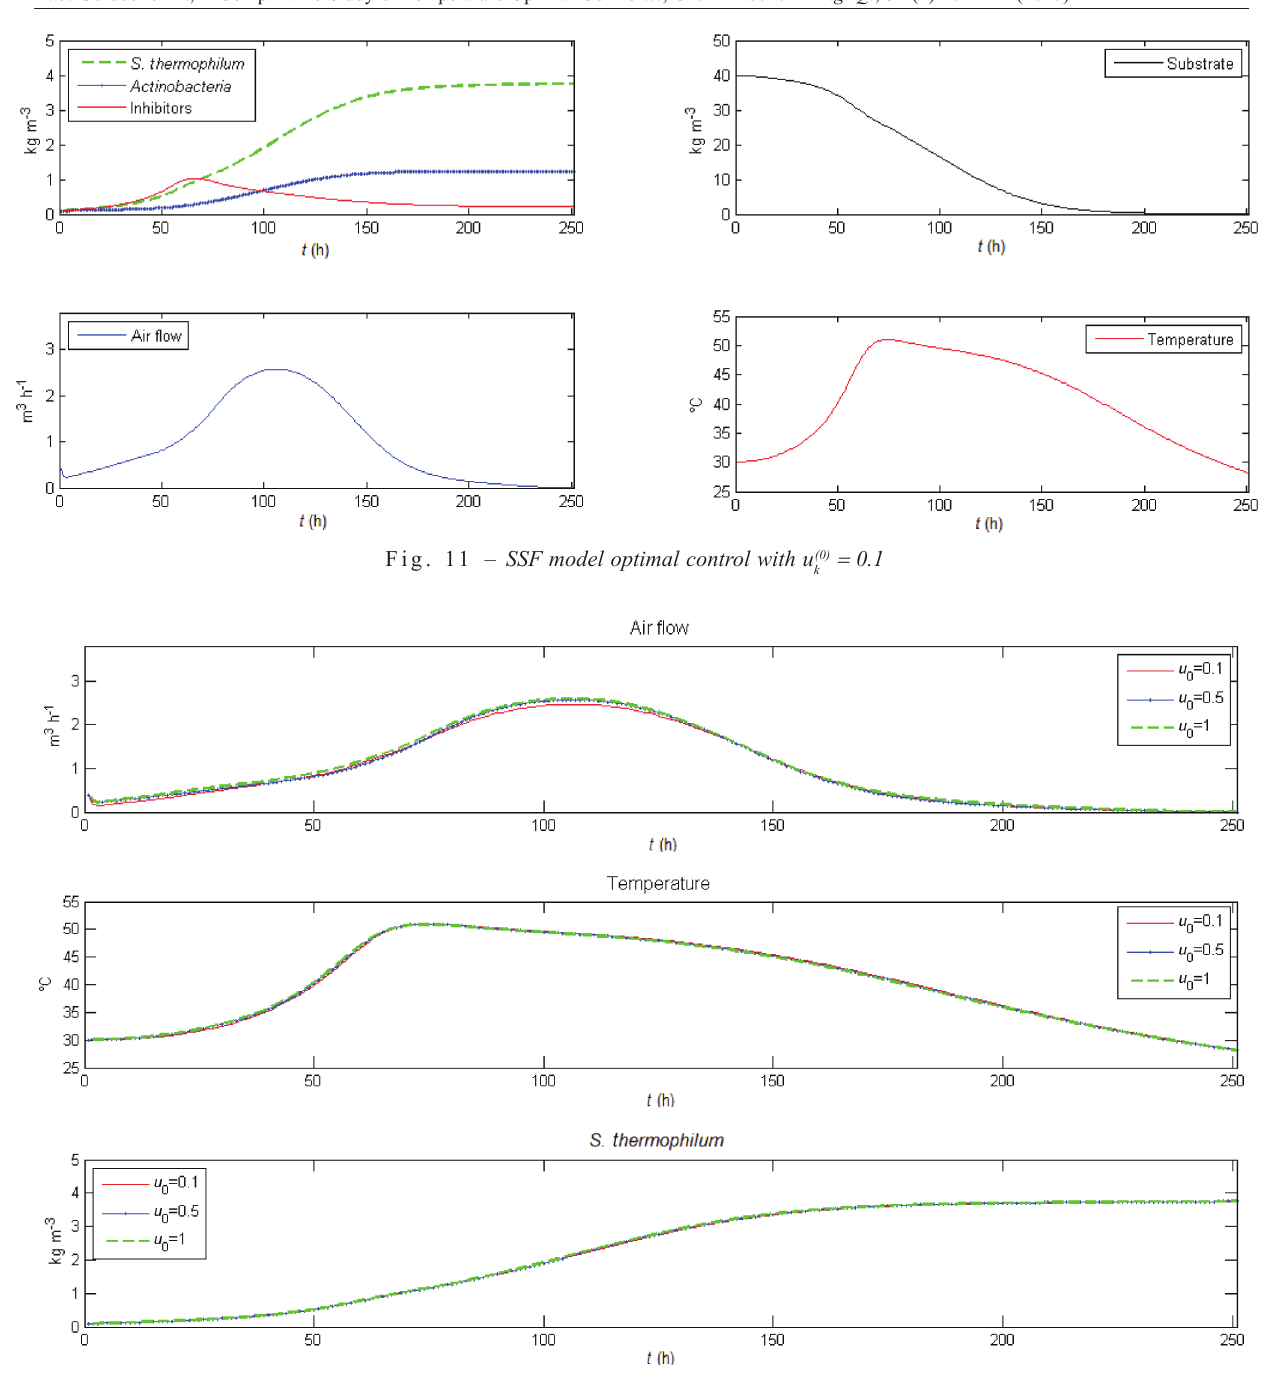
Fig. 12 – SSF model optimal control with u k(0)